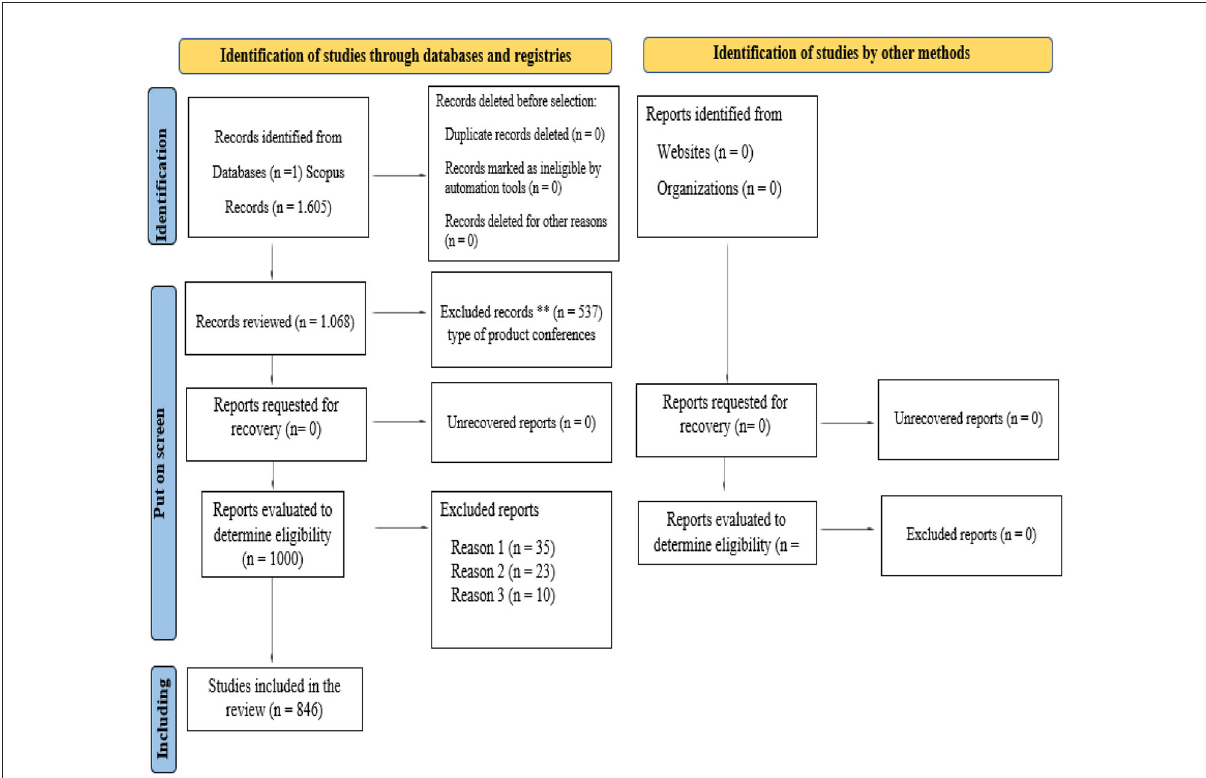
FIGURE1 PRISMA. Source: Own elaboration using Prisma Statement 2020. http://www.prisma-statement.org/. Source: Page et al., 2021.